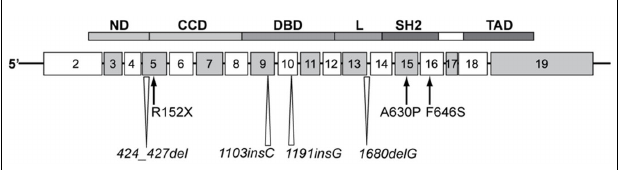
FIGURE 2 | Homozygous STAT5B mutations identified in patients with GH insensitivity, IGF-I deficient, severely growth retarded, and immune compromised. Schematic of the STAT5b protein modular structure encoded by corresponding exons is as indicated. CCD, coiled-coiled domain; DBD, DNA binding domain; L, linker; ND, N-terminal domain; SH2, Src-homology 2-domain; STAT, signal transducer and activator of transcription;TAD, transactivation